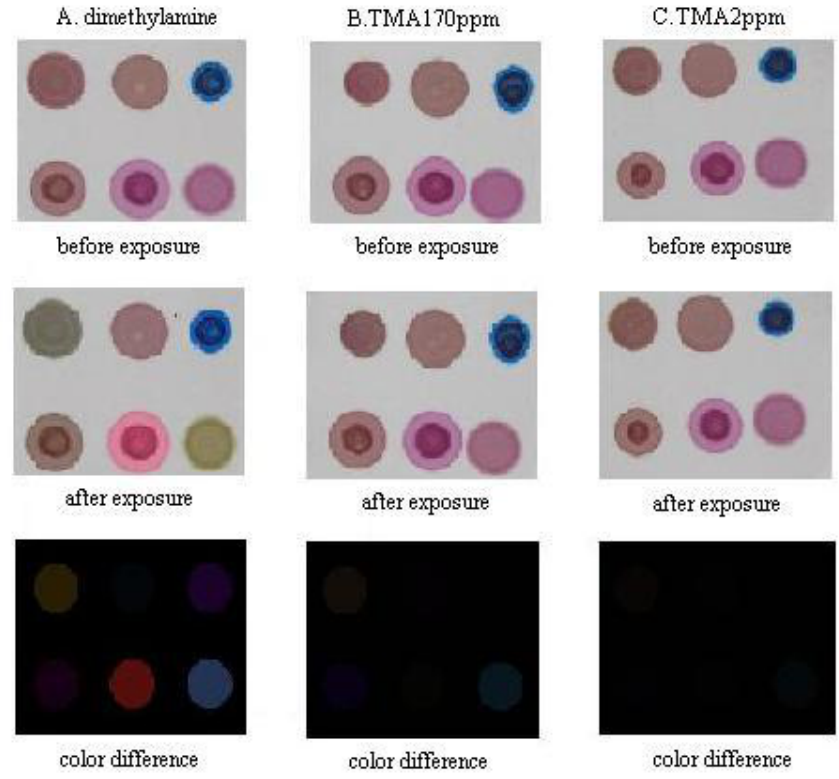
Figure 4. CSA‟s images before and after exposure for 5 minutes to: (A) dimethylamine; (B) 170 ppm of TMA; and (C) 2 ppm of TMA. The color difference images reflect the mean color change of each dye on the